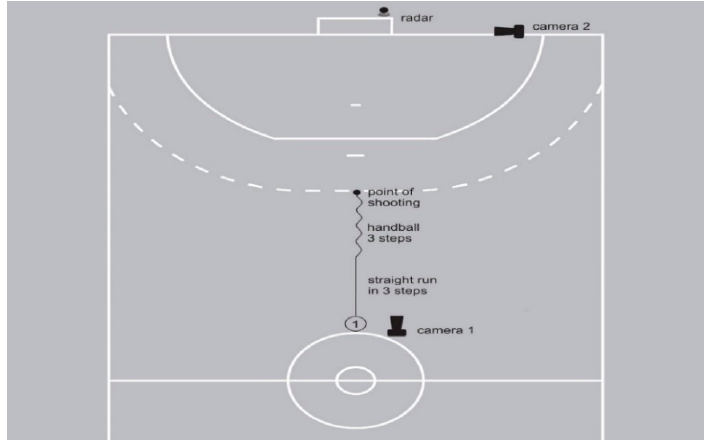
Int. J. Environ. Res. Public Health 2021 , 18 , 10809 Figure 1. Sketch of the workplace. Figure 1. Sketch of the workplace.